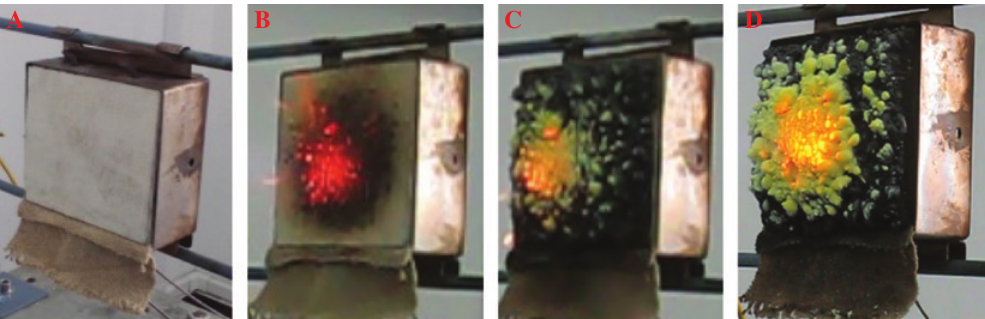
Figure 8: Evolution of the intumescent coating during